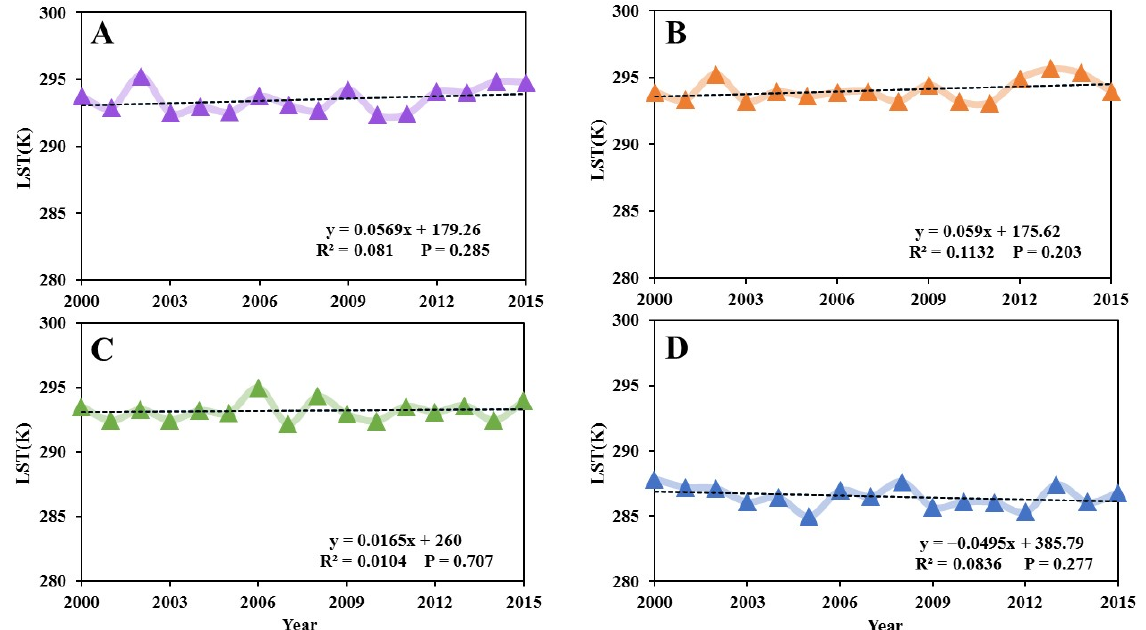
Figure 6. Trend of land surface temperature from 2000 to 2015 (( A ) Jinan City, ( B ) Zhengzhou City, ( C ) Lanzhou City, ( D ) Xining City).